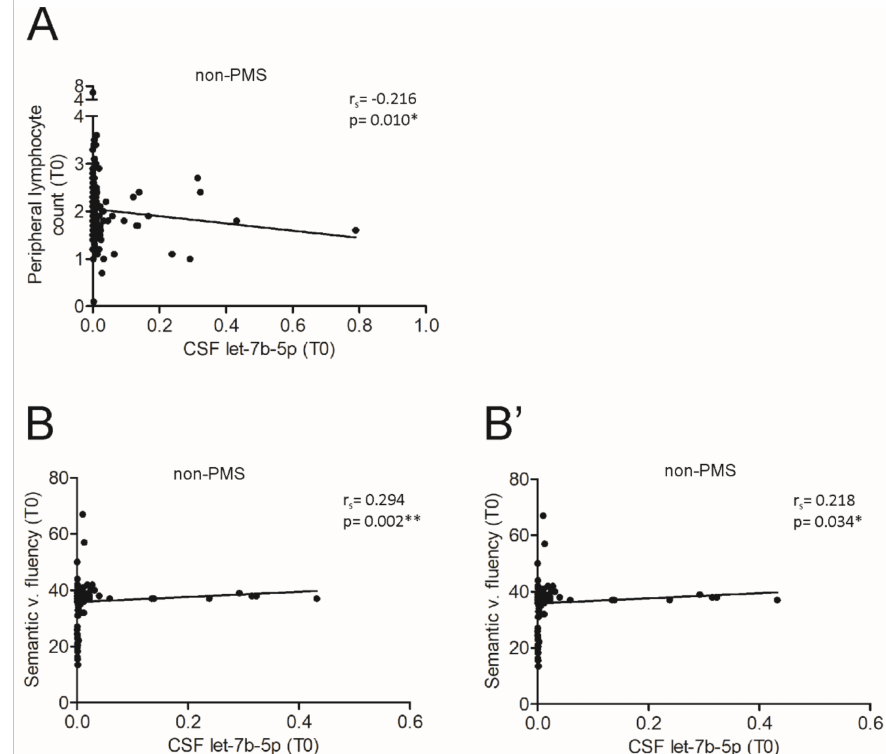
Figure 5. The correlations with inflammation and cognitive performances revealed a putative protective role of let-7b-5p in non-progressive phase. ( A ) Correlation plot between let-7b-5p levels and the count of peripheral T cells of non-PMS (n = 140) at T0. A negative correlation was observed (Spearman’s correlation: r s = − 0.216, * p < 0.01). ( B , B’ ) Correlation plot between let-7b-5p levels and Scheme 106. and Phonemic (n = 95) verbal fluency of non-PMS patients at T0. A positive correlation was observed in both executive and categorical memory functions (Spearman’s correlation, B: r s = − 0.294, p < 0.01; B’: r s = 0.218, ** p <